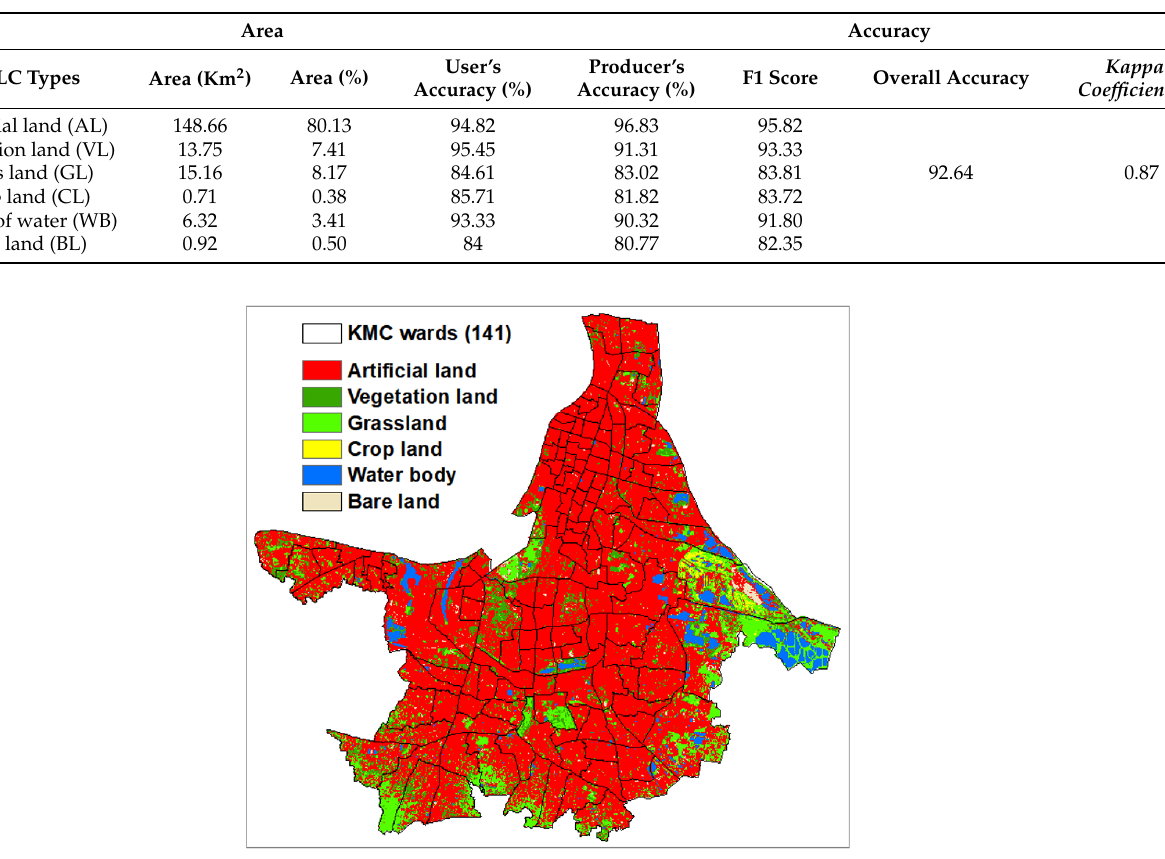
Table 5. Area of each LULC type and the user’s, producer’s, F1 score, overall accuracy, and kappa coefficient for LULC classification.